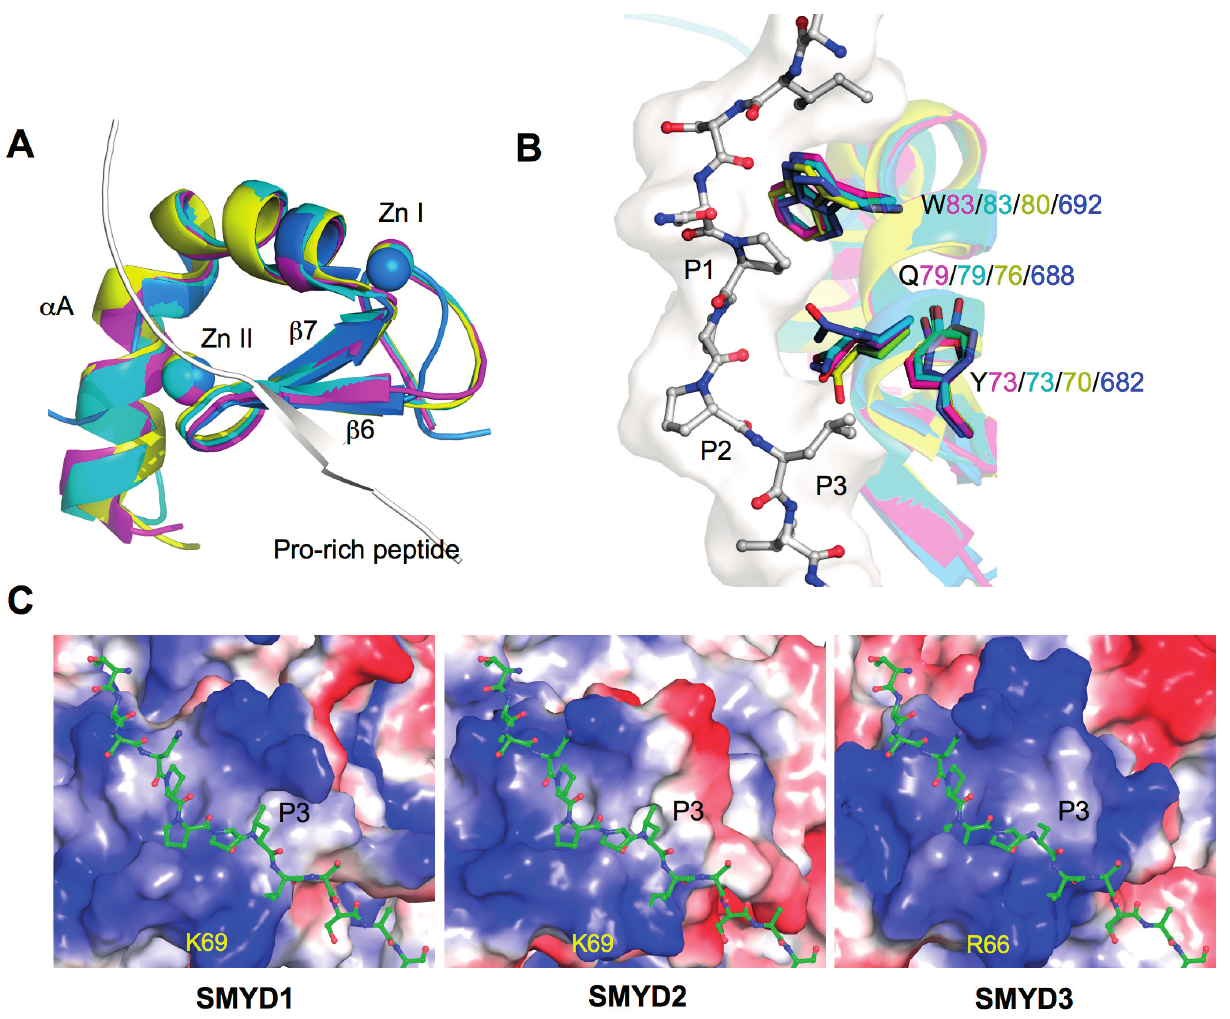
Figure 2. Structure of MYND domains. ( A ) Structural superposition of the MYND domains of SMYD and AML1/ETO (PDB code: 2ODD). MYND is represented by ribbon and colored in magenta (SMYD1), cyan (SMYD2), yellow (SMYD3), and blue (AML1/ETO). Proline-rich peptide bound to AML1/ETO is depicted by ribbon; ( B ) Superposition of the peptide binding pockets. Putative peptide interacting residues are colored according to the scheme in ( A ). The proline-rich peptide bound to AML1/ETO is depicted by balls-and-sticks; and ( C ) Surface representation of the MYND domains. Coloring is according to the electrostatic potential: red, white, and blue correspond to negative, neutral, and positive potential, respectively. The vacuum electrostatics/protein contact potential was generated by PyMOL. The proline-rich peptide, represented by balls-and-sticks, is modeled by superposition of the MYND domain of SMYD and